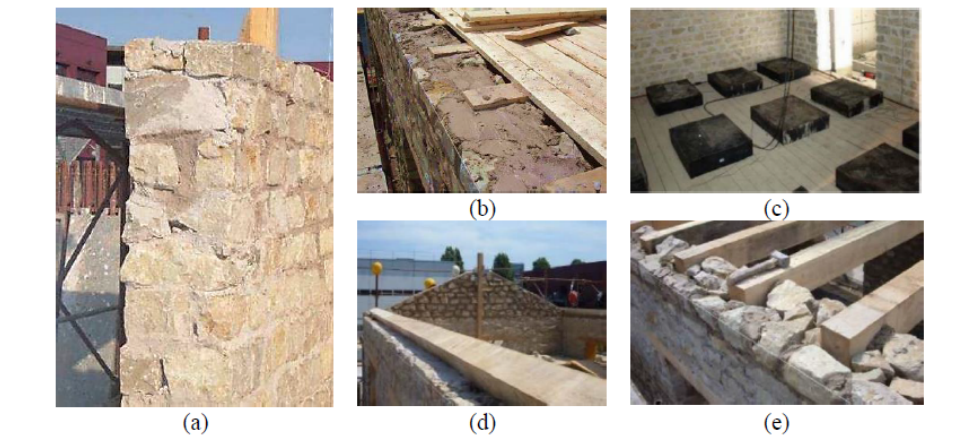
Figure 6. Building 1 details: ( a ) masonry wall. ( b , c ) timber floor. ( d , e ) timber roof [47–49,68].